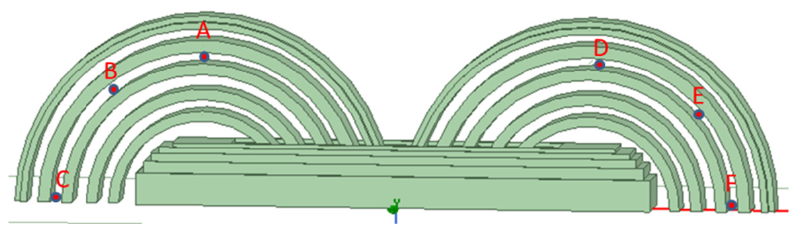
Figure 12. Leakage measurement points are selected from A–F.